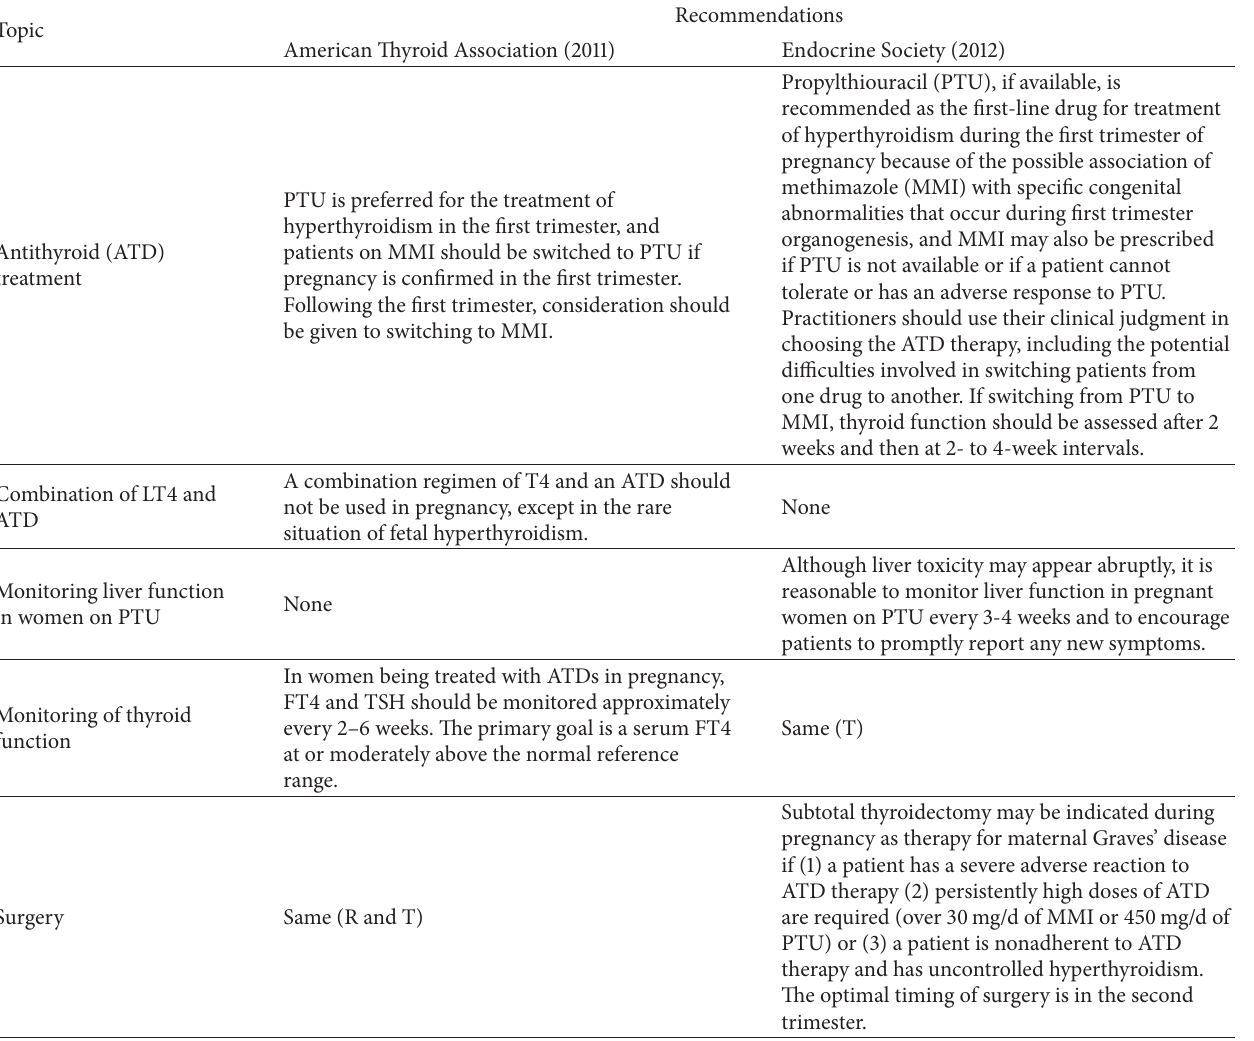
Table 2: Comparison of recommendations of American Thyroid Association and Endocrine Society on the treatment of hyperthyroidism in